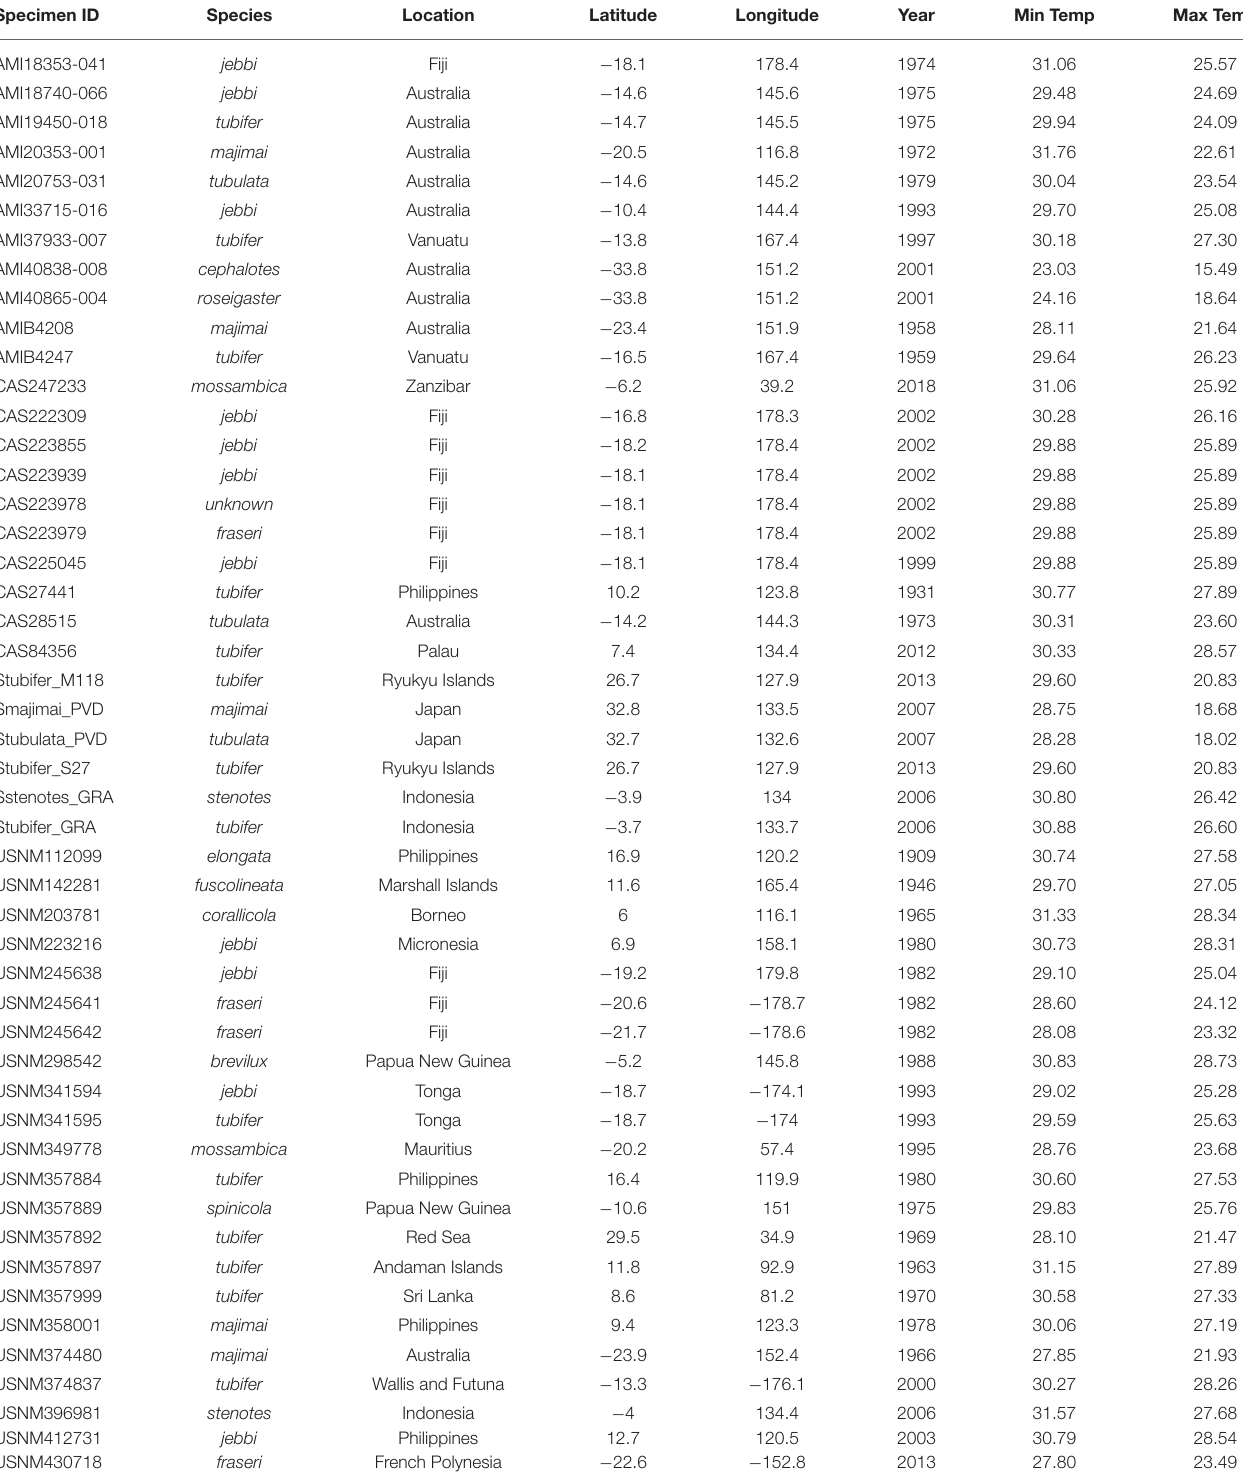
TABLE 1 | Information for the Siphamia specimens sampled in this